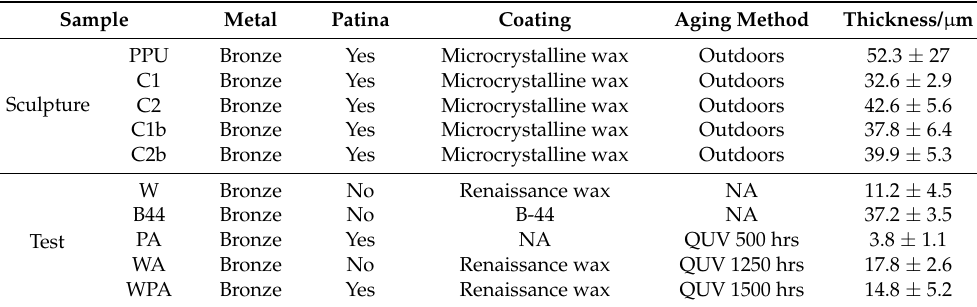
Table 1. Summary of details for the Olympic Sculpture Park sculptures and test plates including the metal substrate, patina, coating material, aging method, and average coating thickness. The reported coating thickness is representative of the entire passive layer, which includes the protective coating (wax, B-44) and the patina if present.